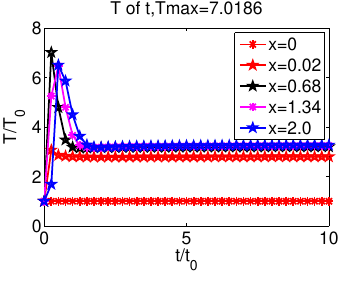
Figure 24. Temperature vs. time t with fixed x